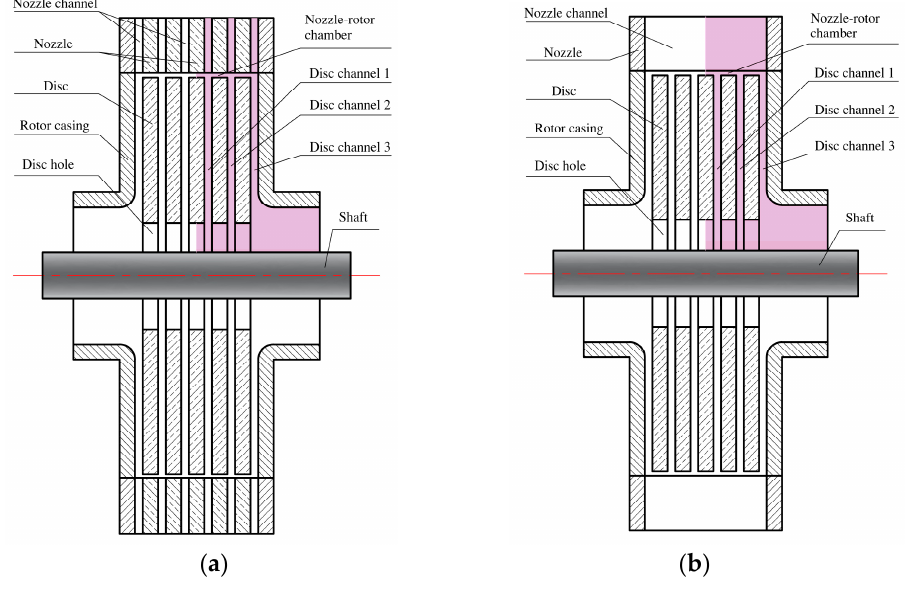
Figure 2. Schematic diagrams of multichannel Tesla turbines [22]. ( a ) One-to-one turbine; ( b ) one-to-many turbine.